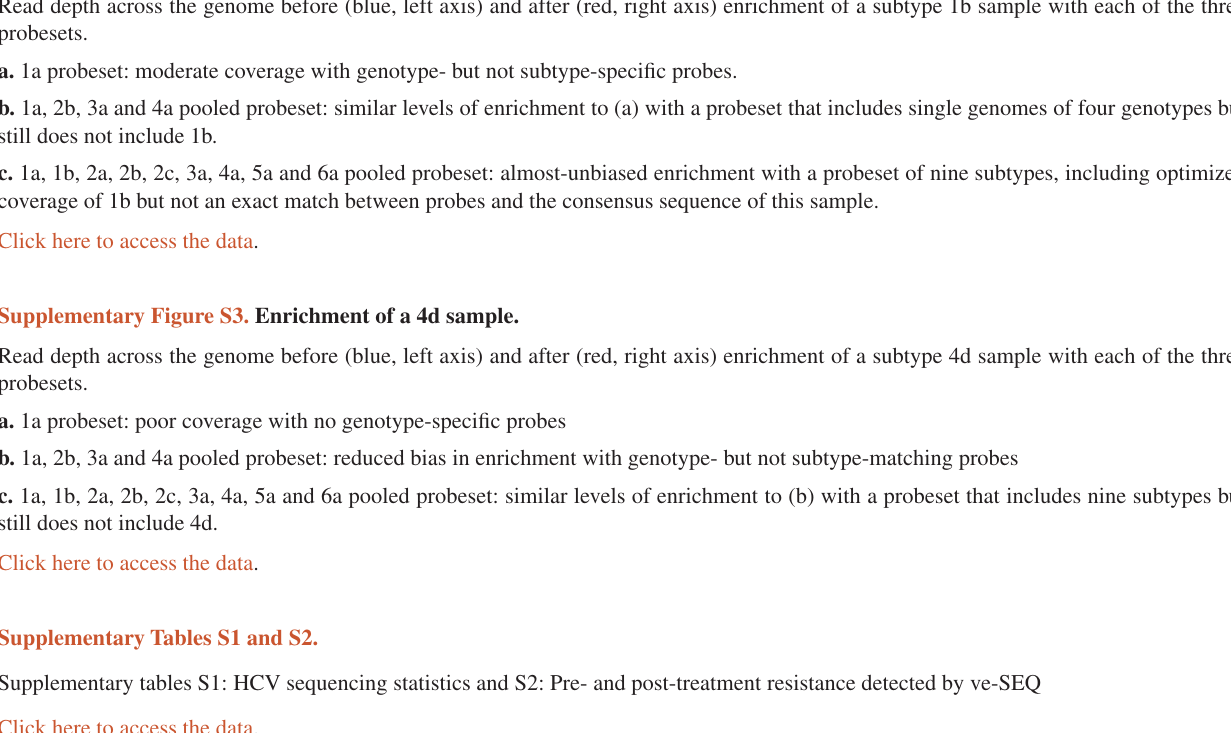
Supplementary Figure S2. Enrichment of a 1b